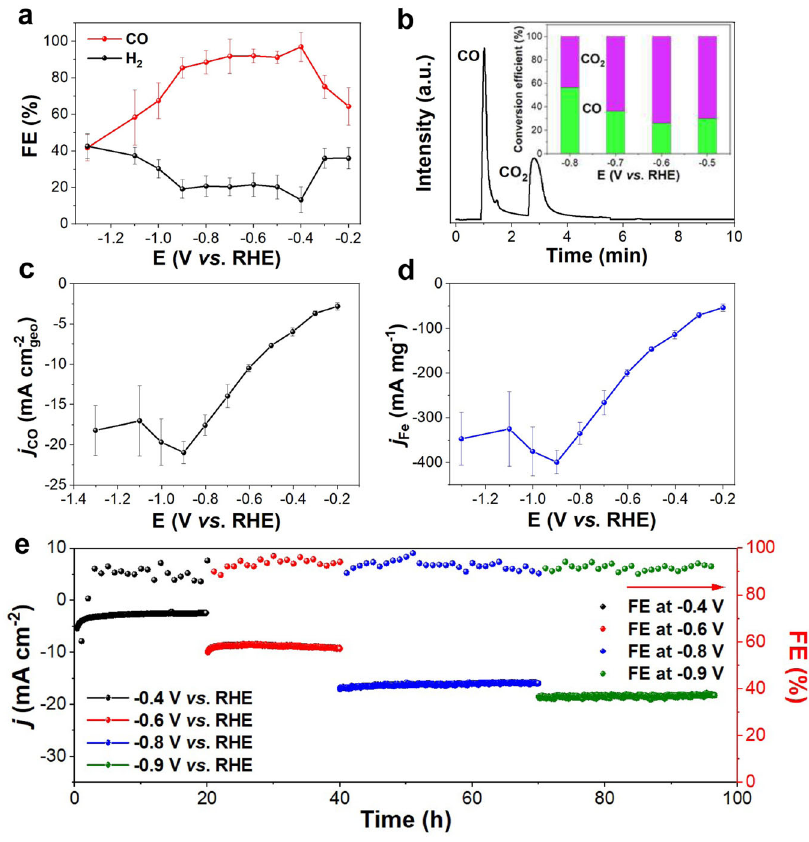
Fig. 3 | CO 2 RR performance of the FeN/Fe 3 N catalyst. a Reduction potential dependentFEsofCOandH 2 . b GCspectrumofthegasproductsuponasinglepass CO 2 conversion(Inset:reductionpotentialdependentCO 2 conversiontoCO). c CO partialcurrentdensityand d correspondingmassactivity. e CO 2 RRcurrentdensity